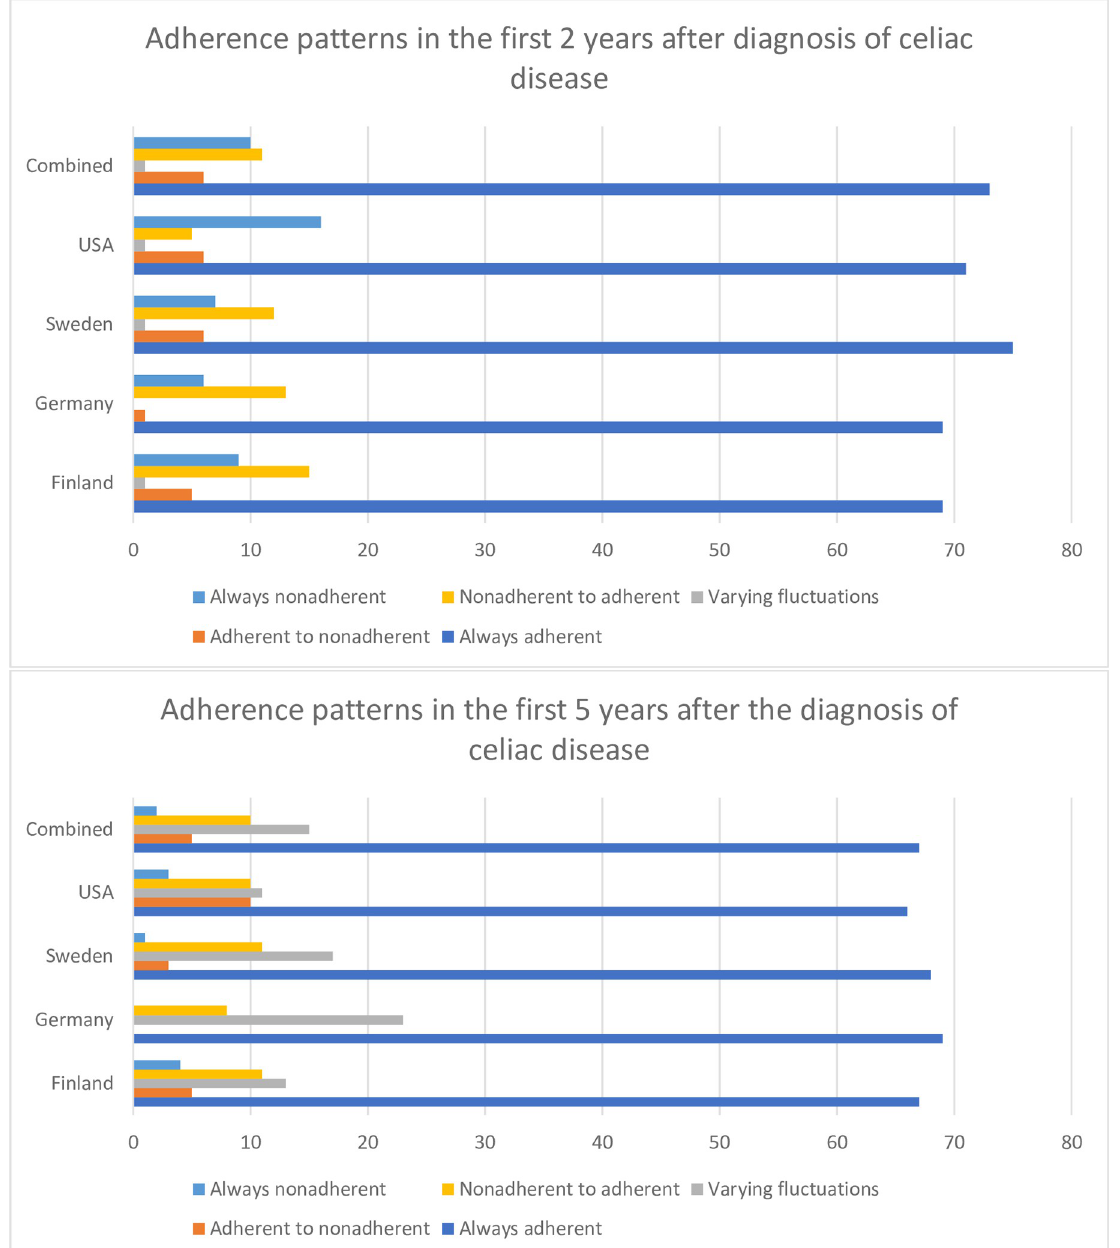
Fig 2. Country variations in adherence. Gluten-free diet adherence patterns stratified by country at 2 and 5 years post the diagnosis of celiac disease.